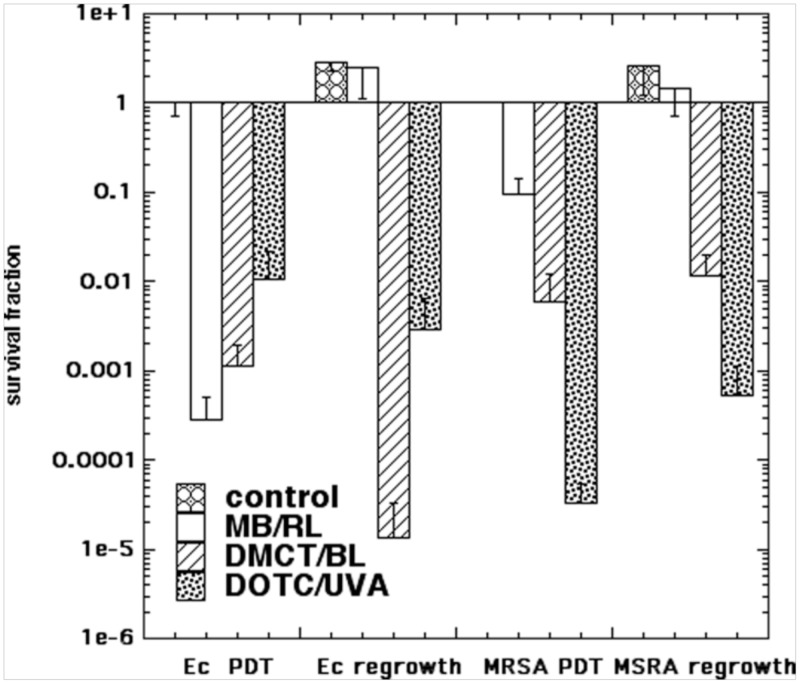
Effect of regrowth in medium after aPDI in PBS.Bacterial cells (E. coli (Ec) or MRSA were incubated in PBS with DMCT or DOTC at 5 μM, or with MB at 8 μM (for E. coli UTI89) or 4 μM (for MRSA), and exposed to 10 J/cm2 of the appropriate light (BL for DMCT; UVA for DOTC; RL for MB). The samples were assayed for CFU and then added to fresh growth medium and incubated overnight and the CFU were determined again.